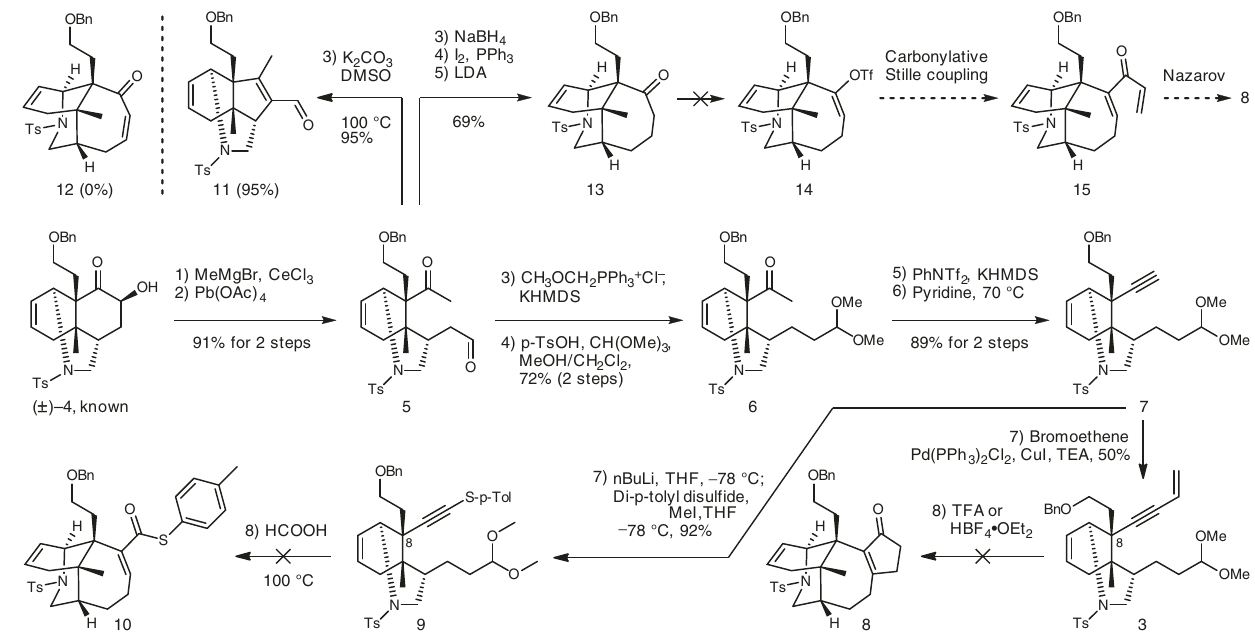
Fig. 3 Initial studies towards the 7/5 ring system. Bn benzyl, KHMDS potassium bis(trimethylsilyl)amide, LDA lithium diisopropylamide, Tf tri fl uoromethanesulfonyl, TFA tri fl uoroacetic acid, TEA triethylamine, Ts